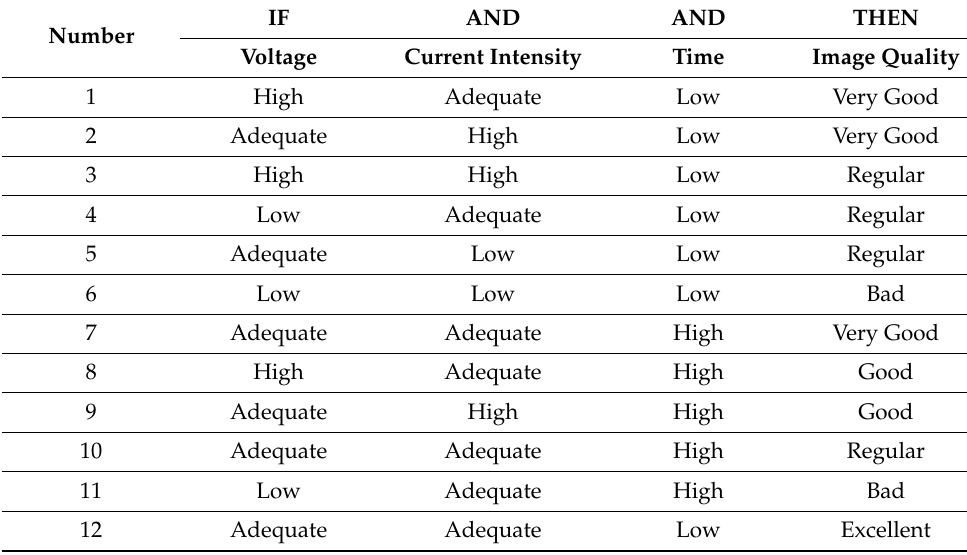
Figure 7. Structure of interval type-3 fuzzy for TV image quality tuning. Table 1. Fuzzy rules for tuning